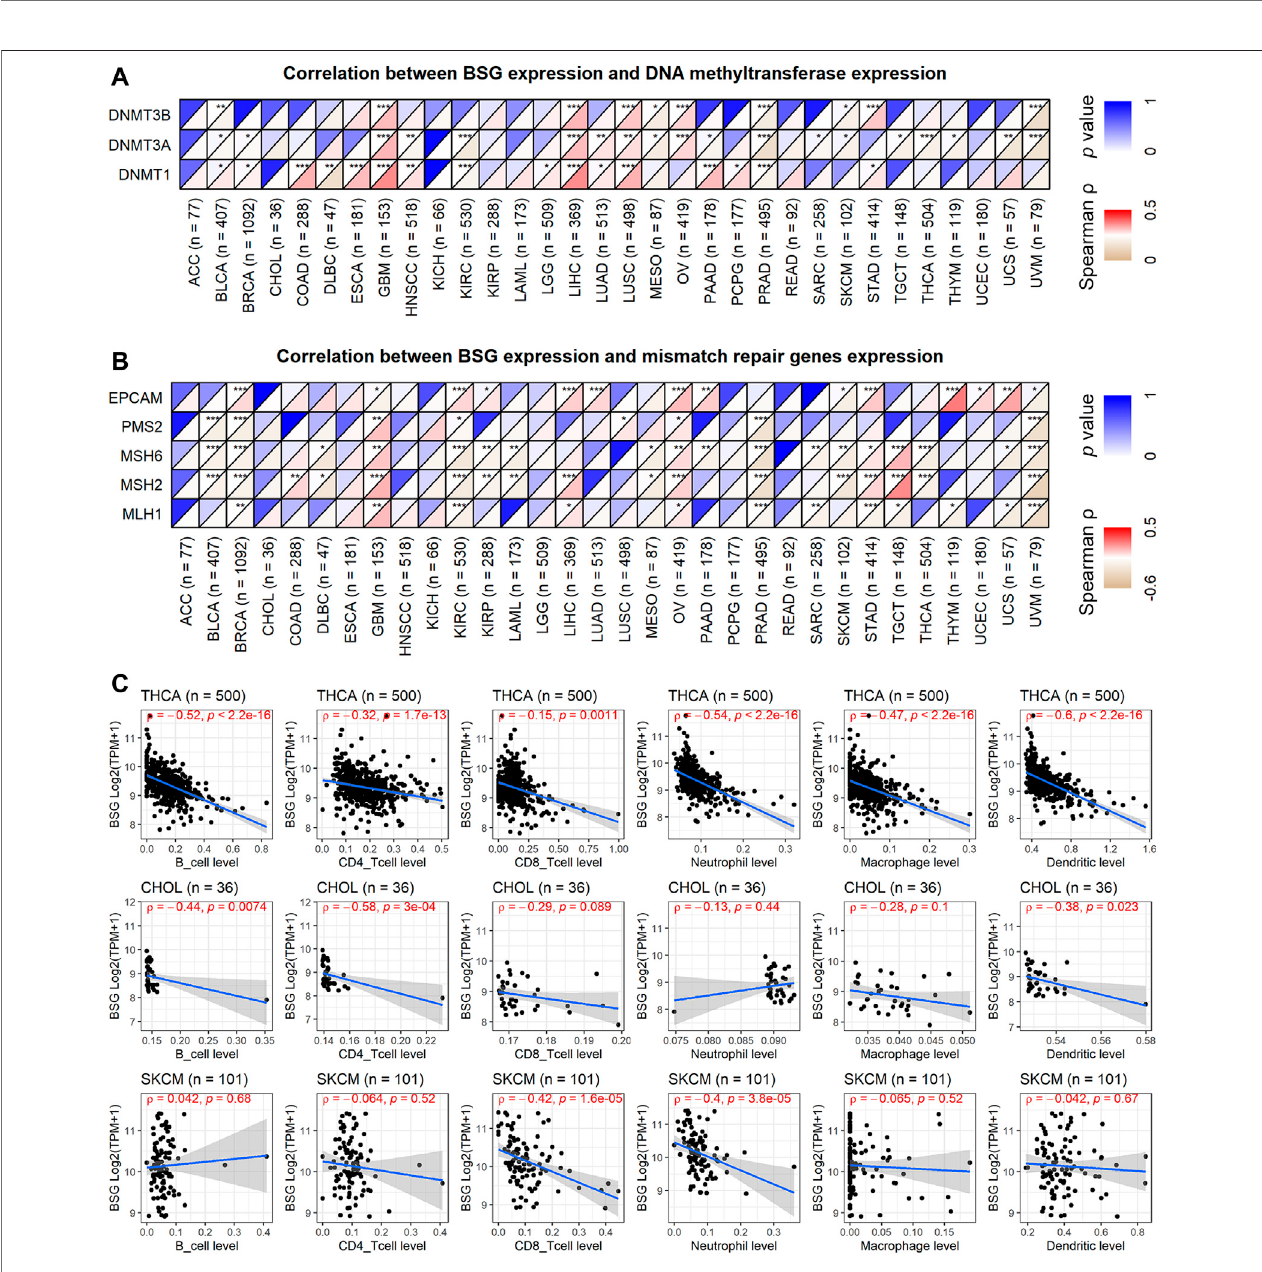
FIGURE 7 | Correlations of BSG expression with DNA methylation, mismatch repair genes expression, and in fi ltration levels of all the six immune cells. (A) BSG expression was positively correlated with the three DNA methyltransferases. (B) BSG expression is signi fi cantly related to the fi ve mismatch repair genes in multiple cancers. (C) BSGexpressionisnegatively associatedwithnearlyallsixtypes ofimmunecellsinthethreecancers.TheSpearman correlation coef fi cient followstheletter “ ρ . ” In (A – C) , the value in parentheses (e.g., “ n = 77 ” for ACC) represents the number of samples. ACC, adrenocortical carcinoma; BLCA, bladder cancer; BRCA, invasive breast carcinoma; CHOL, cholangiocarcinoma; COAD, colon adenocarcinoma; DLBC, lymphoid neoplasm diffuse large B-cell lymphoma; ESCA, esophageal carcinoma; GBM, glioblastoma multiforme; HNSC, head and neck squamous cell carcinoma; KICH, kidney chromophobe; KIRC, kidney renal clear cell carcinoma; KIRP, kidney renal papillary cell carcinoma; LAML, acute myeloid leukemia; LGG, brain lower grade glioma; LIHC, liver hepatocellular carcinoma; LUAD, lung adenocarcinoma; LUSC, lung squamous cell carcinoma; MESO, mesothelioma; OV, ovarian serous cystadenocarcinoma; PAAD, pancreatic adenocarcinoma; PCPG, pheochromocytoma and paraganglioma; PRAD, prostate adenocarcinoma; READ, rectum adenocarcinoma; SARC, sarcoma; SKCM, skin cutaneous melanoma; STAD, stomach adenocarcinoma; TGCT, testicular germ cell tumors; THCA, thyroid carcinoma; THYM, thymoma; UCEC, uterine corpus endometrial carcinoma; UCS, uterine carcinosarcoma; UVM, uveal